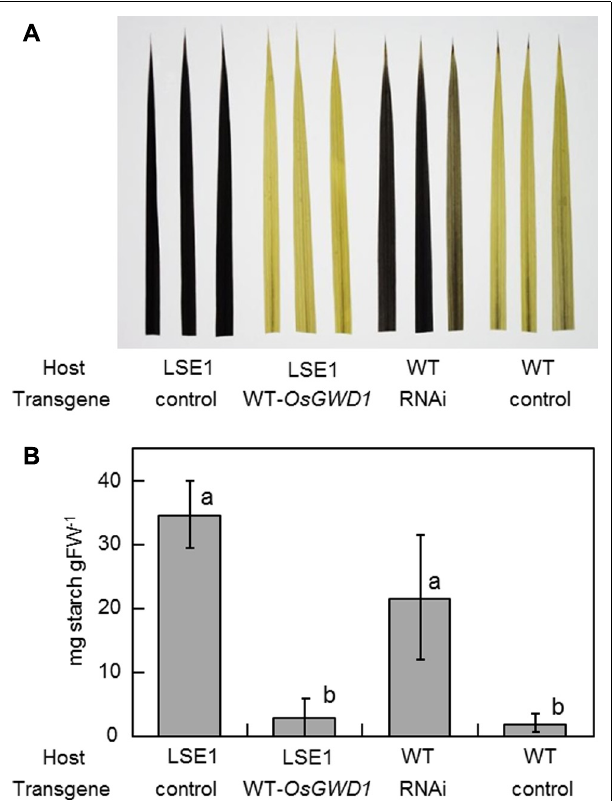
FIGURE 5 | Functional complementation of LSE1 mutation and RNAi suppression of OsGWD1 in wild-type plants. The uppermost fully elongated leaf blades were sampled from the transgenic rice plants at the panicle formation stage.The combinations of the host and the transgene are specified below the panel. Empty vectors were introduced as the controls for each assay. Accumulation of starch was (A) visualized by iodine in three independent transgenic plants or (B) determined enzymatically using the samples from six independent transgenic plants for each combination. Data represent the mean ± SE ( n = 6) and different letters indicate significant differences ( p < 0.05,Tukey’s